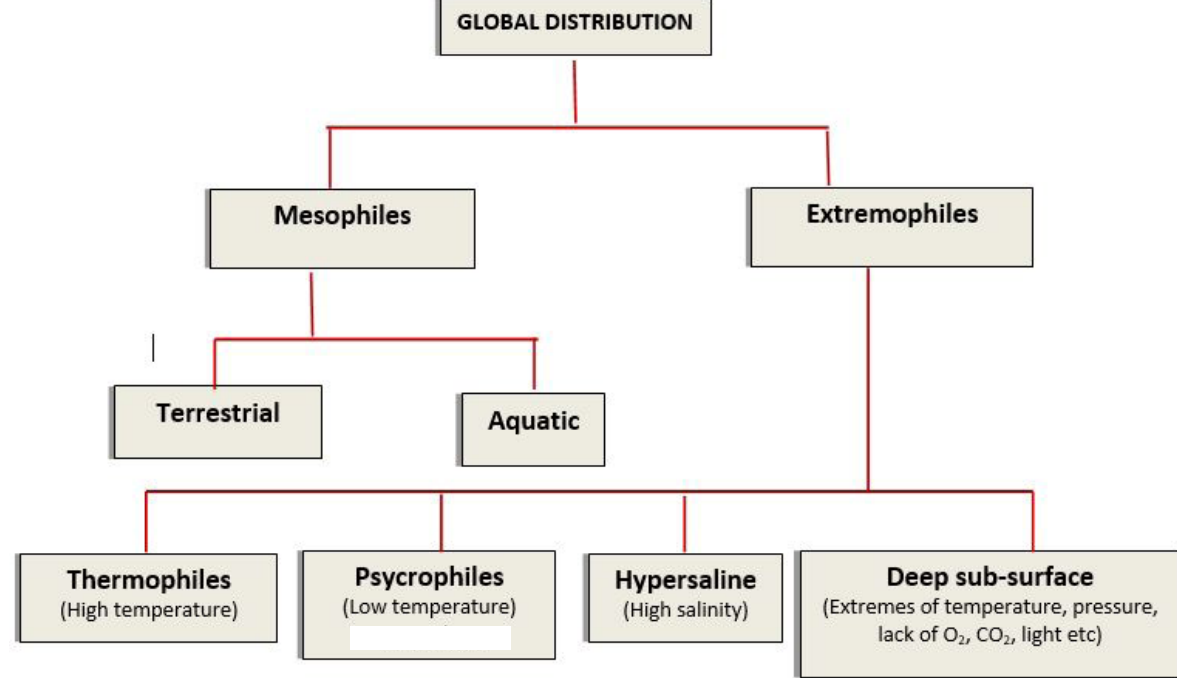
Figure 2: Major distributional groups of microorganisms.